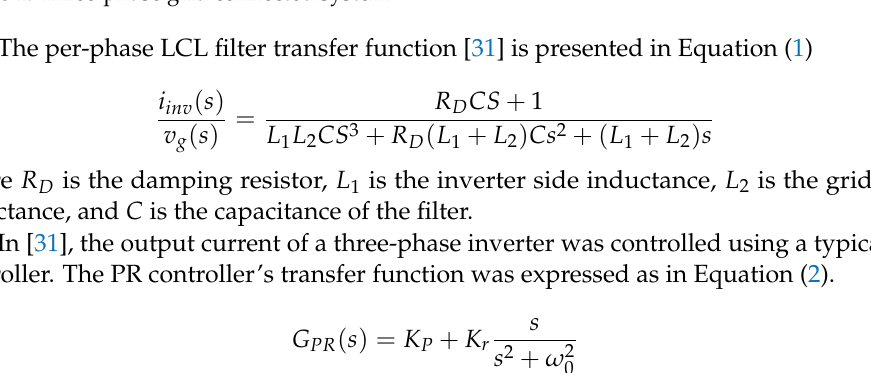
Figure 1. Three-phase grid connected